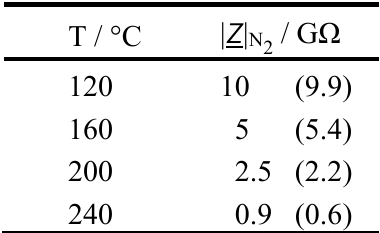
Figure 6. Response curves (| Z | vs. c(H